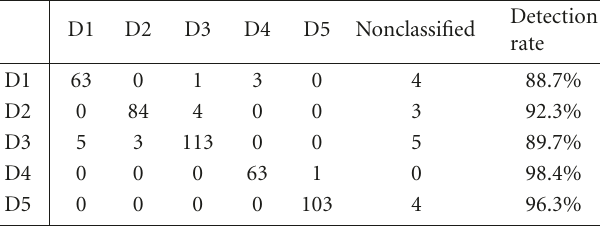
Table 4: Classification results using training and test data from net- work A.